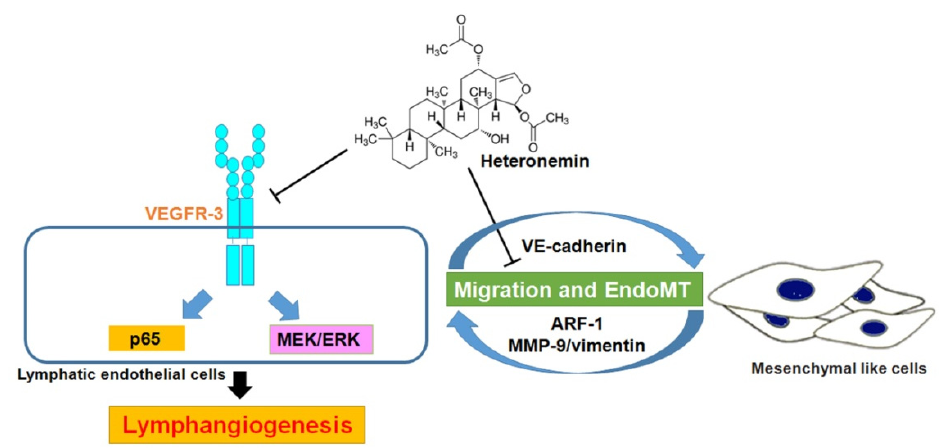
Figure 8. Schema of heteronemin-induced anti-lymphangiogenic mechanism in human lymphatic endothelial cells. This study reveals heteronemin as a promising anti-lymphangiogenic agent. Het- eronemin may possess anti-lymphangiogenesis effect by reducing VEGFR-3 and its downstream NF- κ B p65 and MEK/ERK signaling pathways and ARF-1, as well as the induction of VE-cadherin and the reduction in MMP-9 and vimentin, which is associated with EndoMT, in human lymphatic endothelial cells. T-shaped lines indicate inhibition.